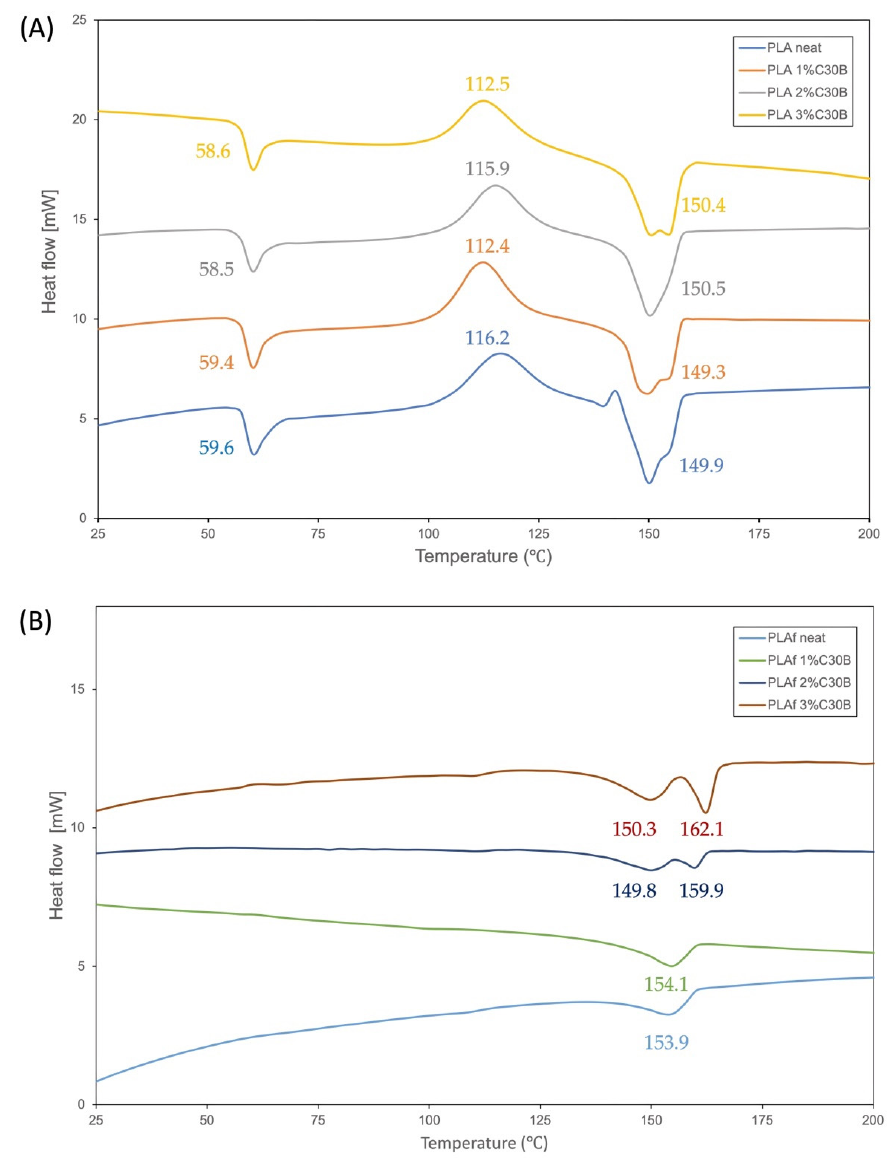
Figure 9. Differential Scanning Calorimetry thermograms of ( A ) PLA films and ( B ) PLA foams (PLAf) of neat and PLA bionanocomposites (Exo-up).